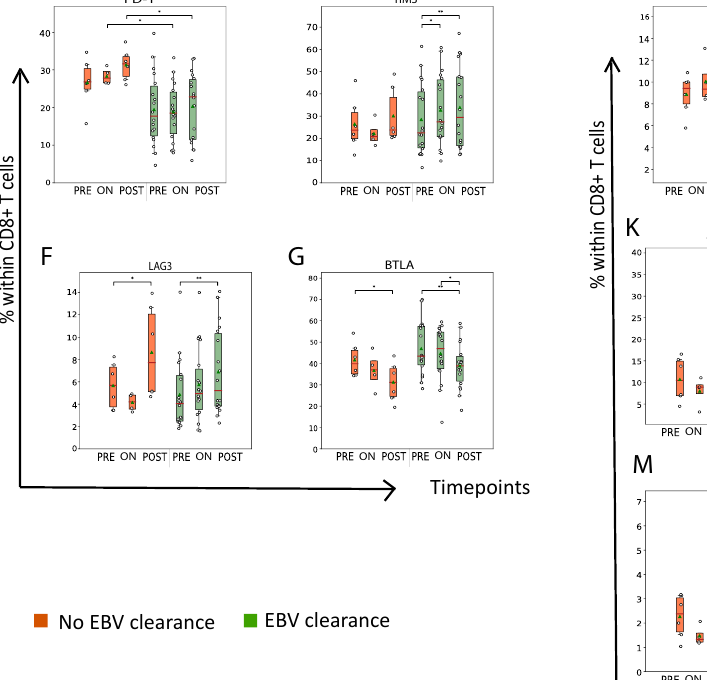
post-RT when compared to non-clearers. ( A ) A UMAP scatter representation of clusters of CD8+ T